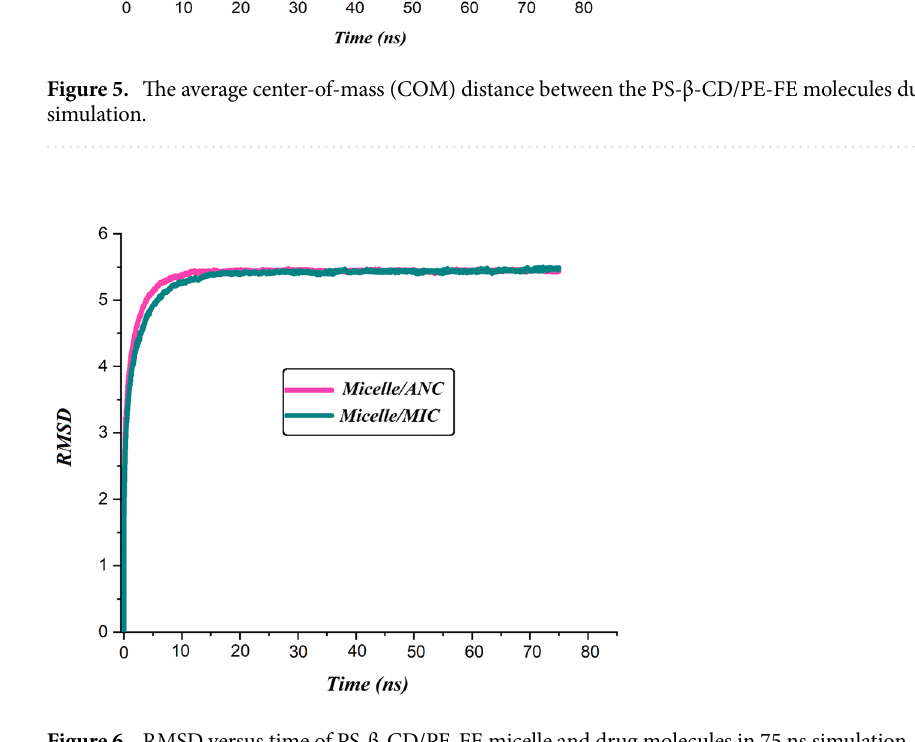
Figure 6. RMSD versus time of PS-β-CD/PE-FE micelle and drug molecules in 75 ns